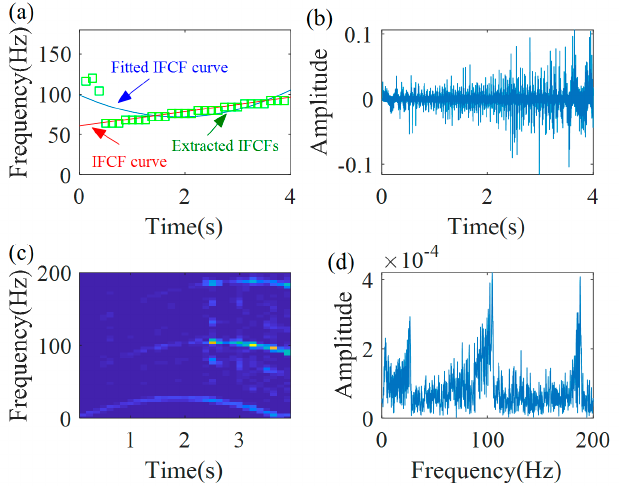
Figure 18. First demodulation results (the traditional GDT): ( a ) extracted IFs; ( b ) demodulated signal; ( c ) TFR; and ( d ) spectrum.